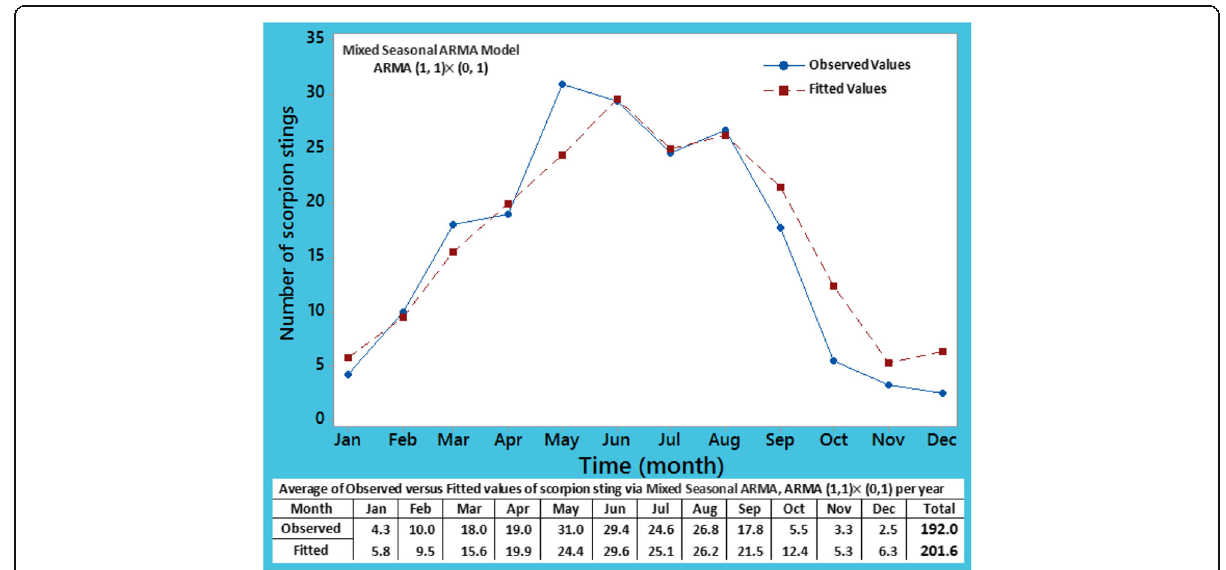
Fig. 9 Plot of average of the observed and fitted values for scorpion sting cases in the years 2012 to 2016 using mixed seasonal ARMA, ARMA (1, 1) × (0, 1) at lag 12